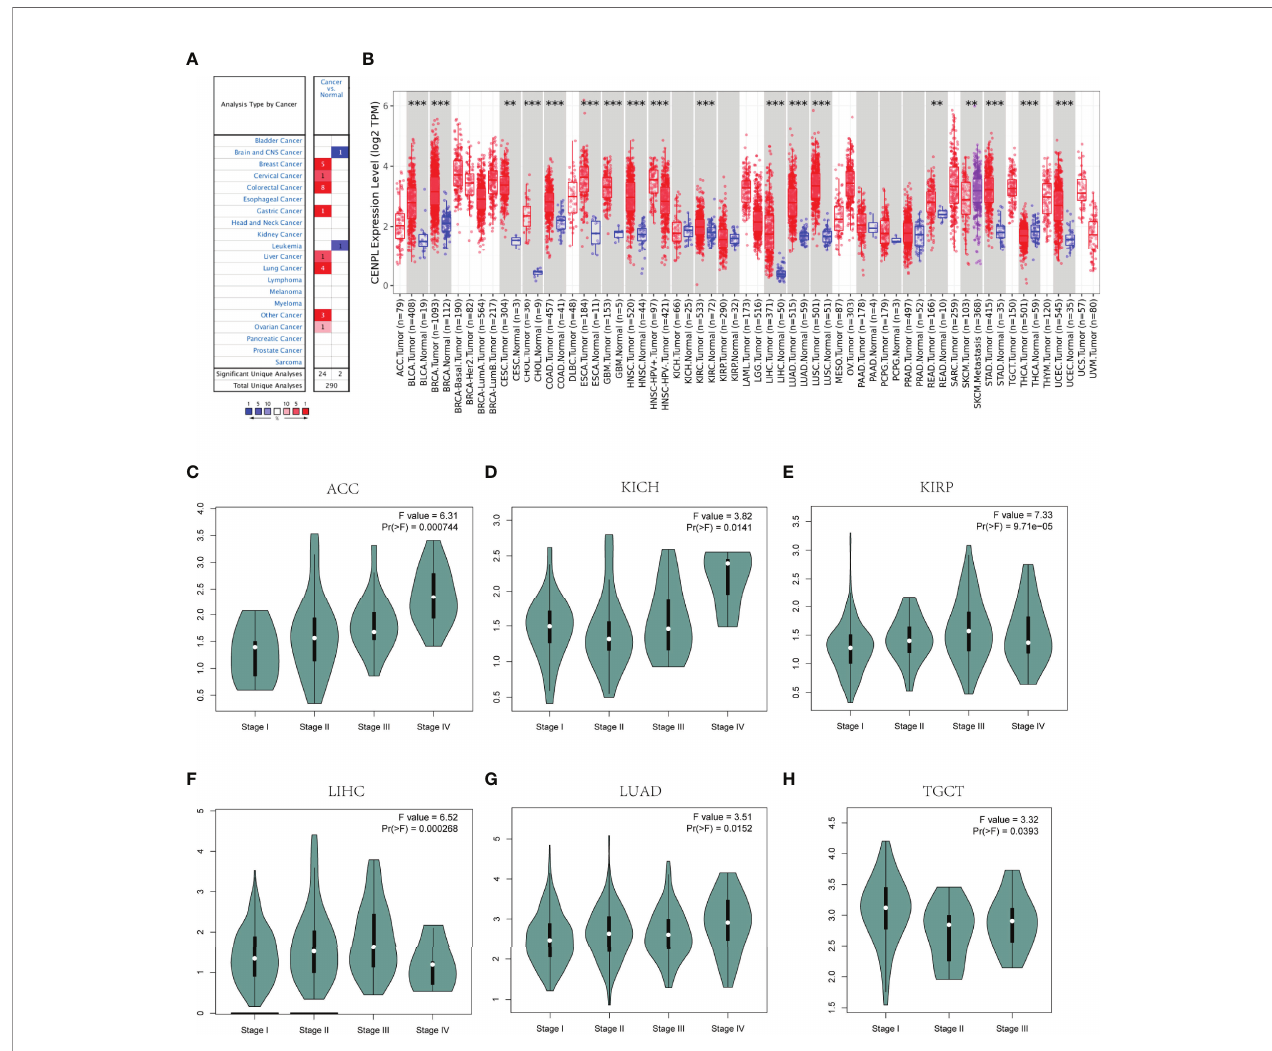
FIGURE 1 | CENPL expression pro fi les in pan-cancer. (A) The expression of CENPL in the Oncomine database. (B) The expression of CENPL in the TIMER 2.0 database. (C – H) The correlation between CENPL expression and cancer stage (** p < 0.01, *** p <